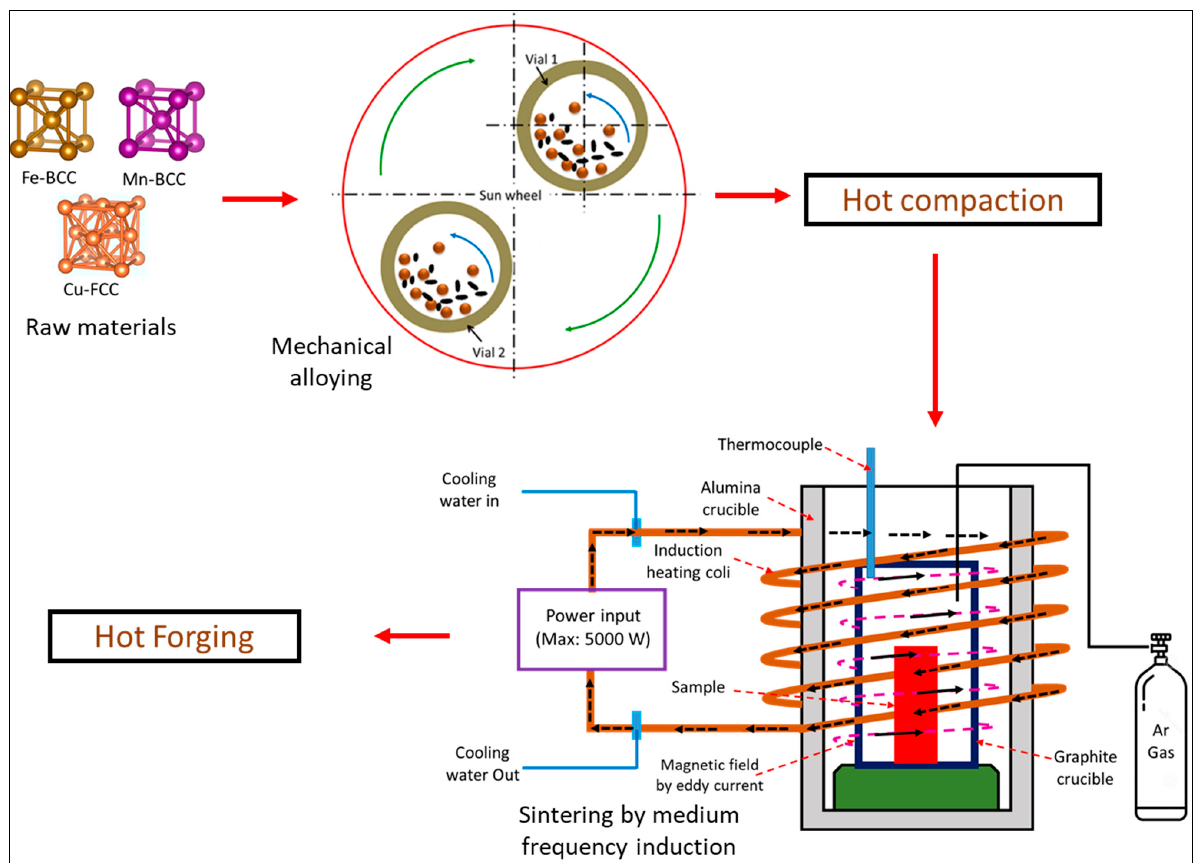
Figure 1. Schematic showing the elemental powders, mechanical alloying process, hot-compaction, sintering using medium frequency furnace, and hot-forging used in the present study .